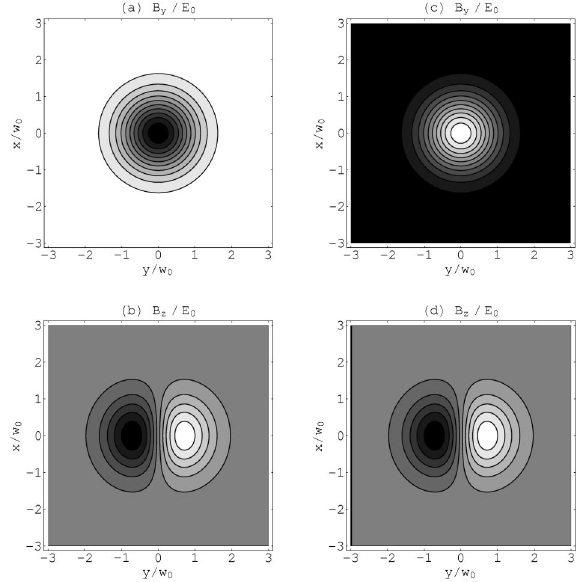
FIG. 4. Same as Fig. 3, but for the magnetic components. (a) and (b) give the fields at !t (cid:3) 0 , and (c) and (d) at !t (cid:3) (cid:21)= 2